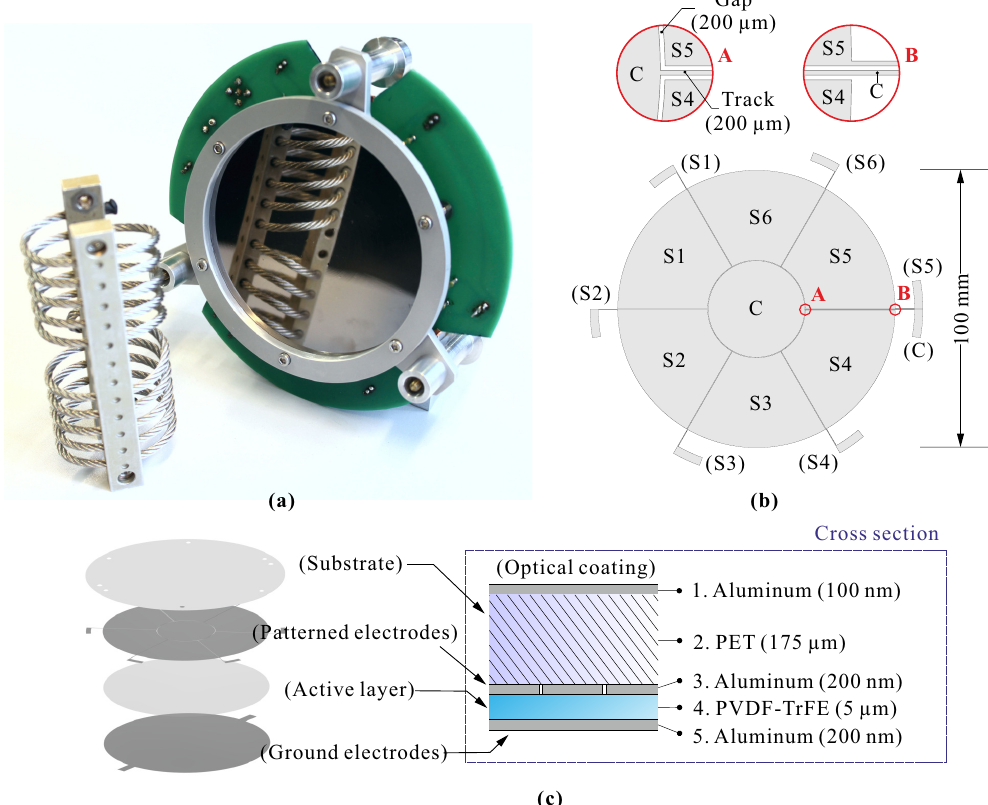
Figure 13. ( a ) View of the 7-electrodes demonstrator mounted in its support. ( b ) Layout of the electrodes and connecting tracks. ( c ) Layout of the various